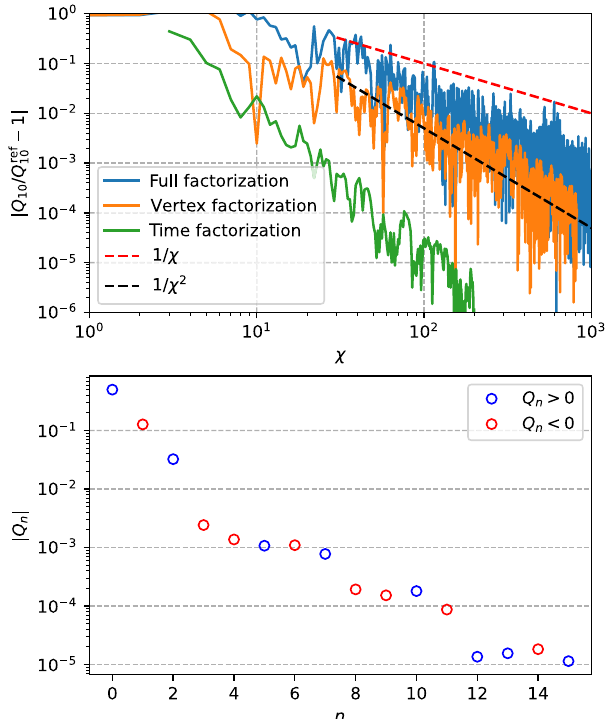
FIG. 18. Double quantum dot. Upper: error of Q 10 versus χ for the three algorithms introduced in the text. The reference value Q ref 10 is obtained using the time factorization algorithm. Lower: j Q n j versus n , obtained using the vertex factorization algorithm. Blue (red) symbols correspond to positive (negative) values 15 of Q . We use γ 0 ¼ 0 . 5 Γ and t n M ¼